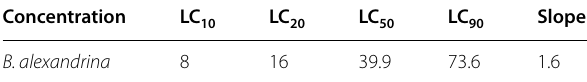
Table 1 Toxicity of plant growth regulator, RIPEX against Biomphalaria alexandrina after 1 day. post exposure Concentration LC 10